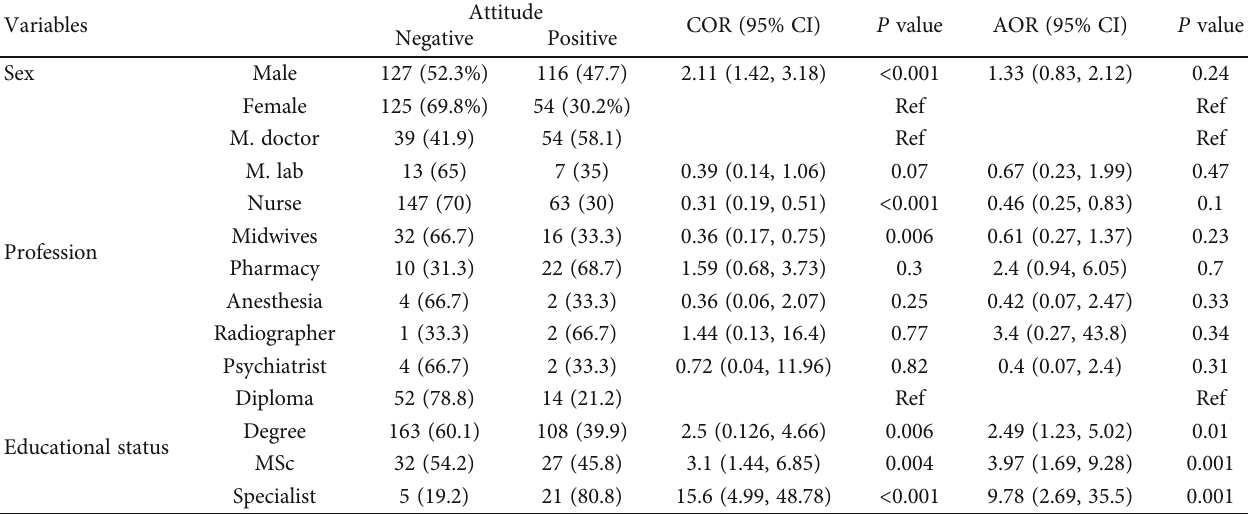
Table 9: Bivariate and multivariate analyses of factors associated with attitude levels o ff HBV infection.